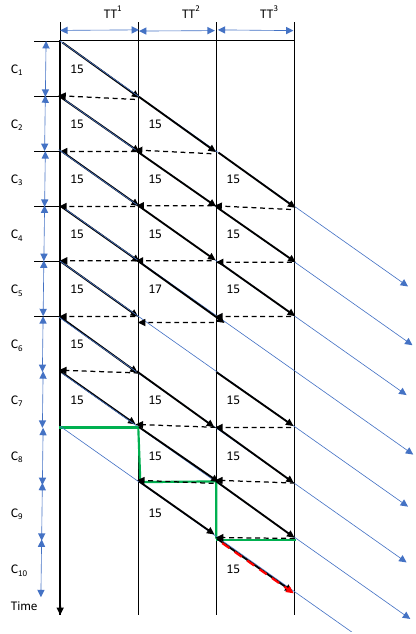
Figure 3. The diagram of employee movement with predicted (C = 15) and real disassembly cycle times (15, 17), transport cycle time (TT = 15) and when the product disassembly and/or transport operations are automated.